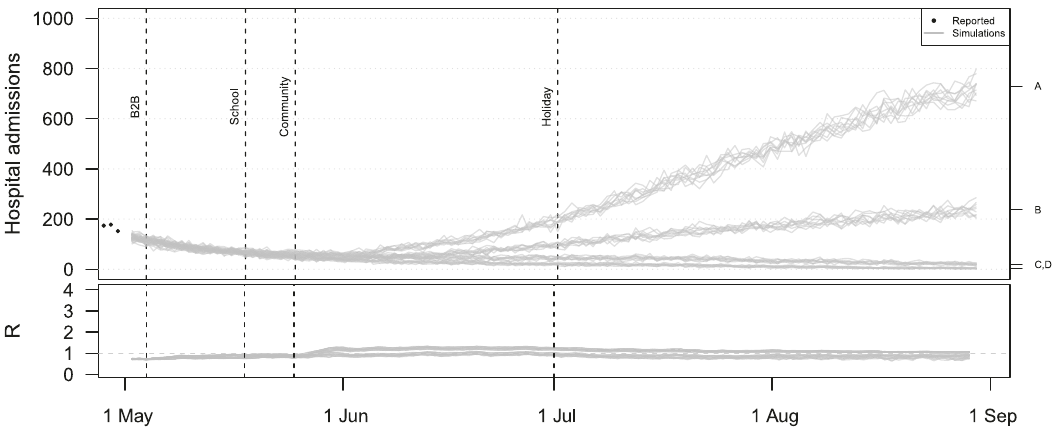
Fig. 1 Hospital admissions and effective reproduction number (R) from the baseline scenario including four mixing assumptions. All simulations include social restrictions from March 14th and the partial school reopening in May. For the B2B, the social mixing after the lockdown is assumed to double from the indicated point in time (marked on the right hand side with A and C) or to remain constant (B,D). Social mixing in the community is assumed to double (A,B) or to remain constant